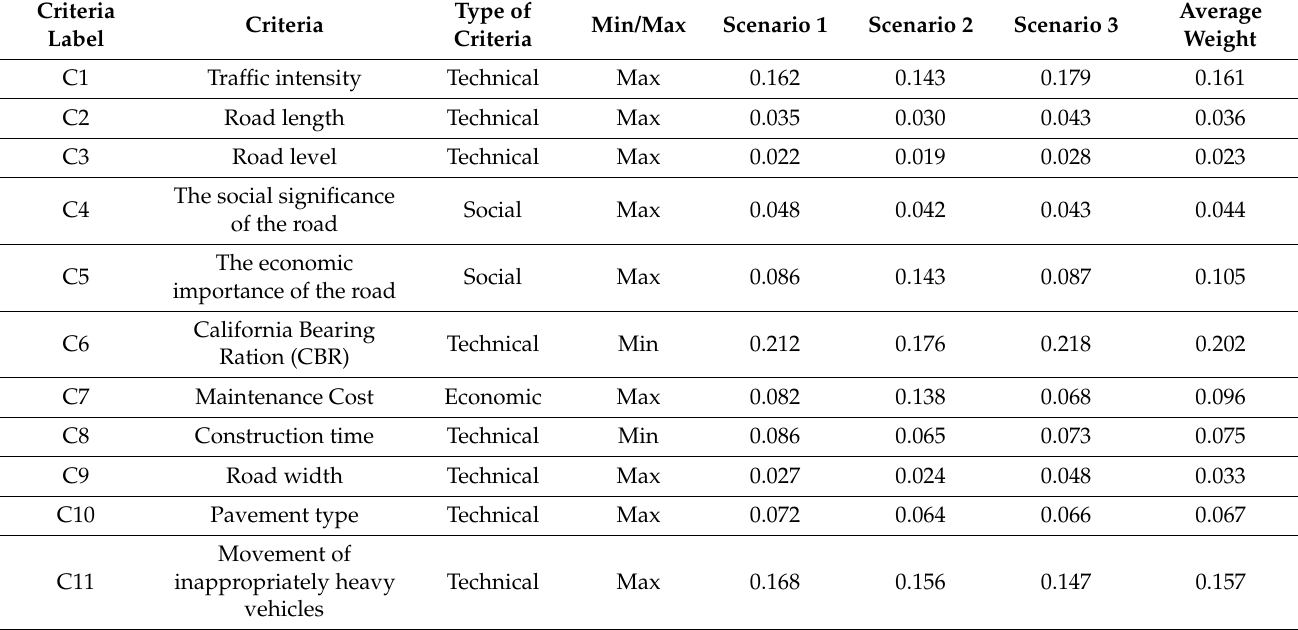
Table 5. Averaged criteria